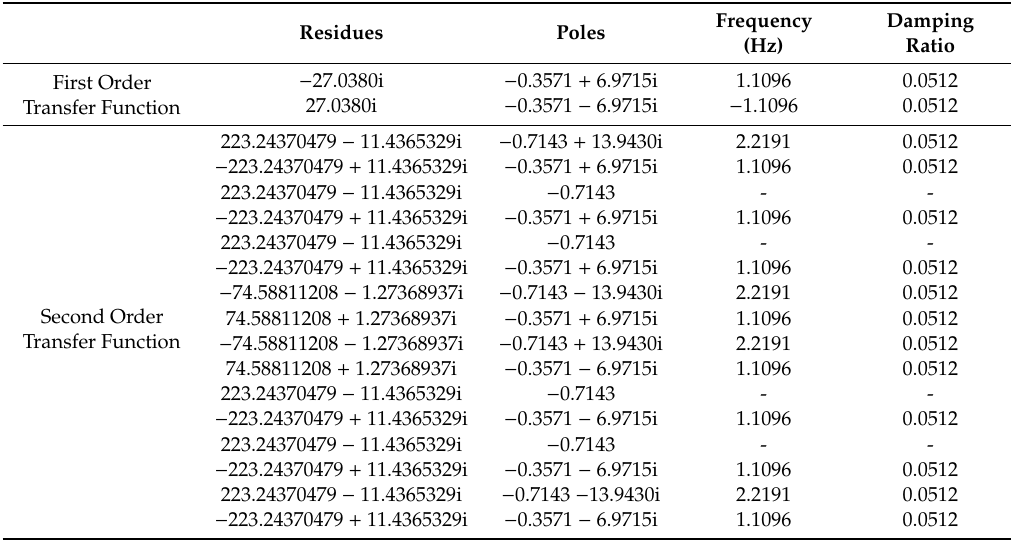
Table 1. Residues, frequencies and damping rations for the linear and nonlinear transfer